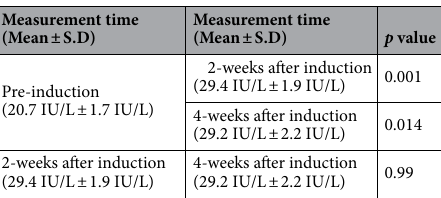
Table 6. Compares the mean aspartate aminotransferase before and after induction.